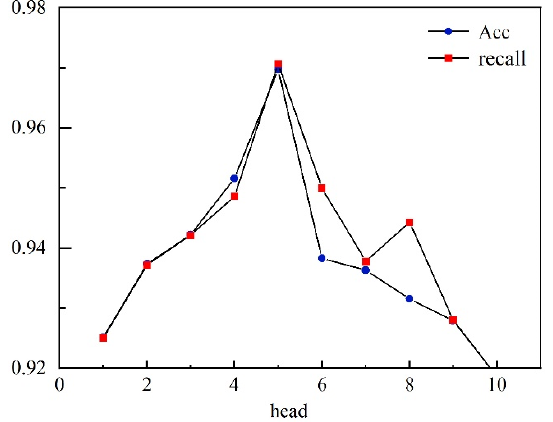
Figure 6. Observe the trends in Acc and recall by changing the number of heads in Transformer.